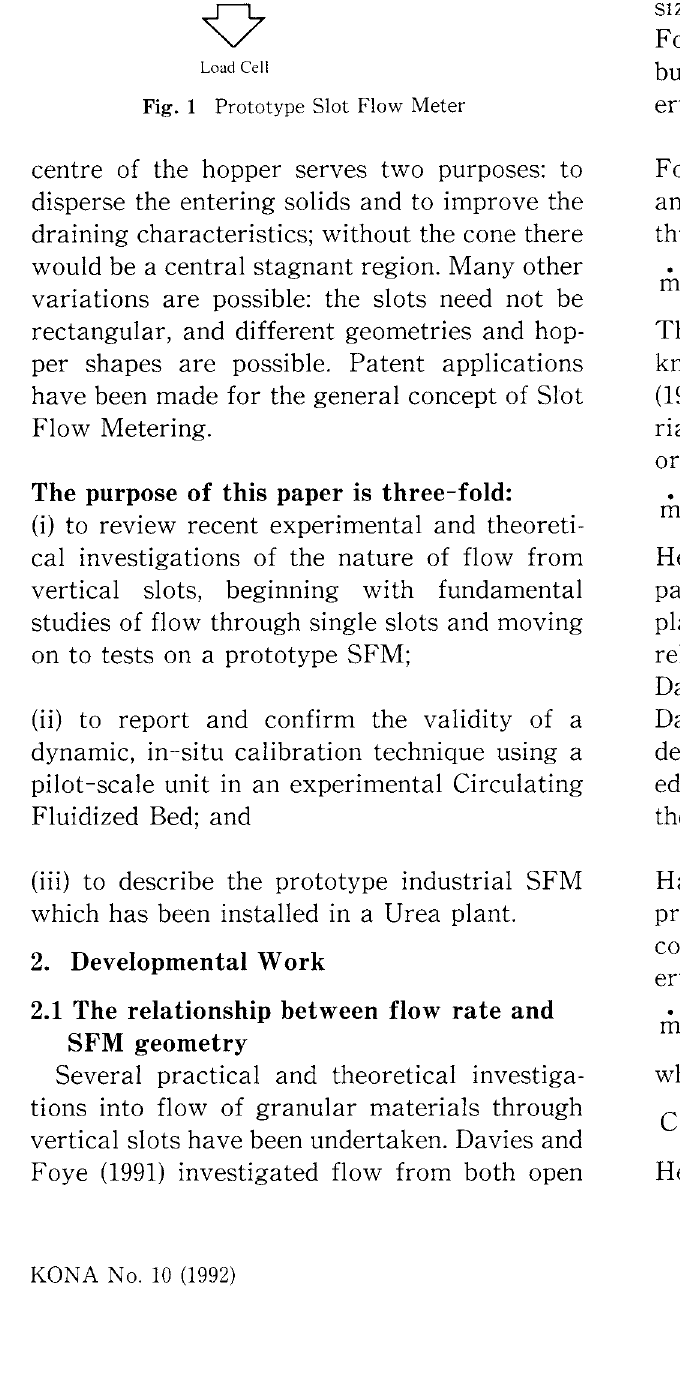
Fig. 1 Prototype Slot Flow